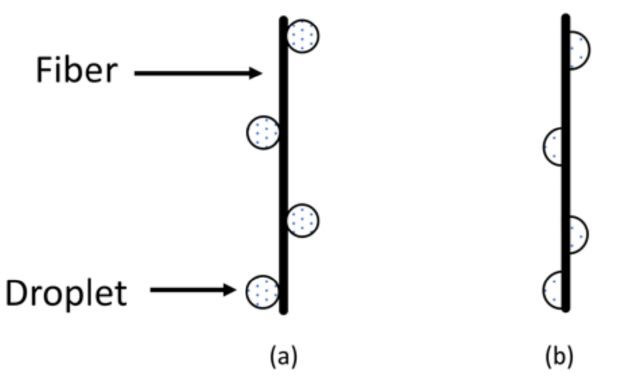
Figure 1. Water droplet adhesion on hydrophobic ( a ) and hydrophilic ( b )